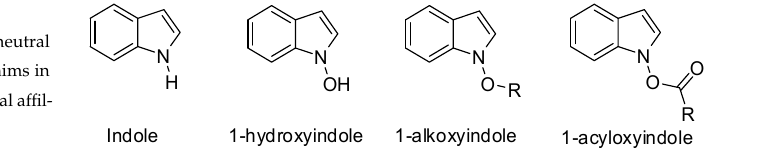
Figure 1. Indole, 1 ‐ hydroxyindole, 1 ‐ alkoxyindole, and 1 ‐ acyloxyindole. Figure 1. Indole, 1-hydroxyindole, 1-alkoxyindole, and